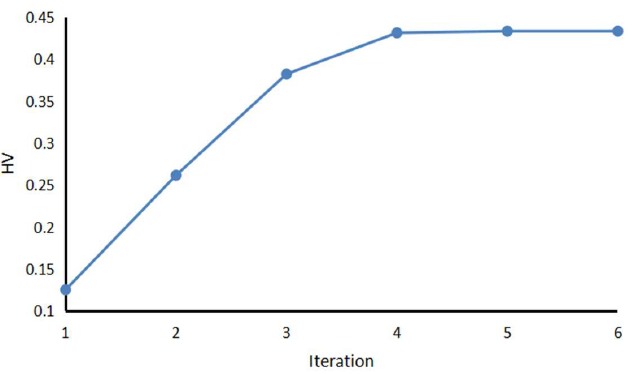
Figure 17. The iteration process of HV in finding solution of crash worthiness using ARBF-MLPA method.